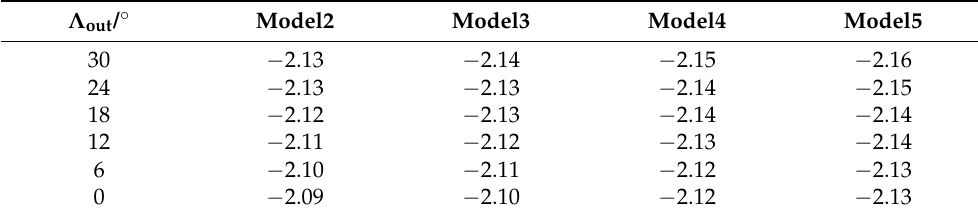
Table 8. The roll damping of pre-selected models under the stability augmentation adjustment when Ma = 0.3.